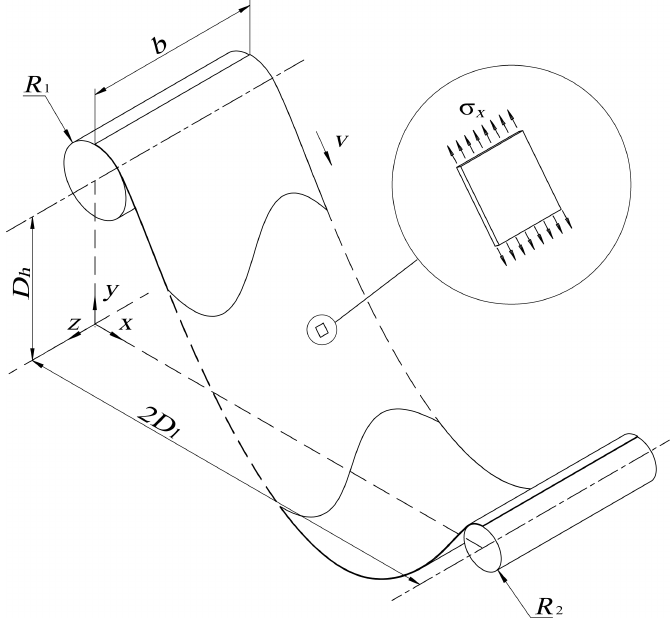
Figure 2. A schematic drawing showing the geometry of the transporting sheet and